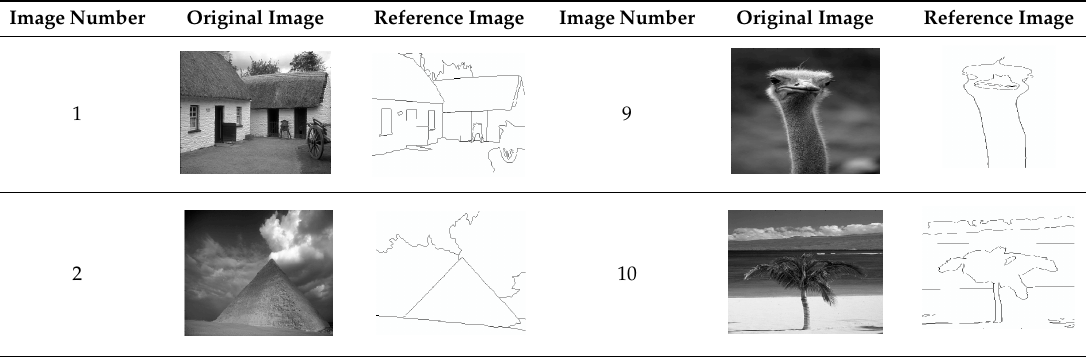
Table 8. A sample of the benchmark database of image segmentation and boundary detection (BSDS)l database with the original images and their reference images. Image Image Number Image Number